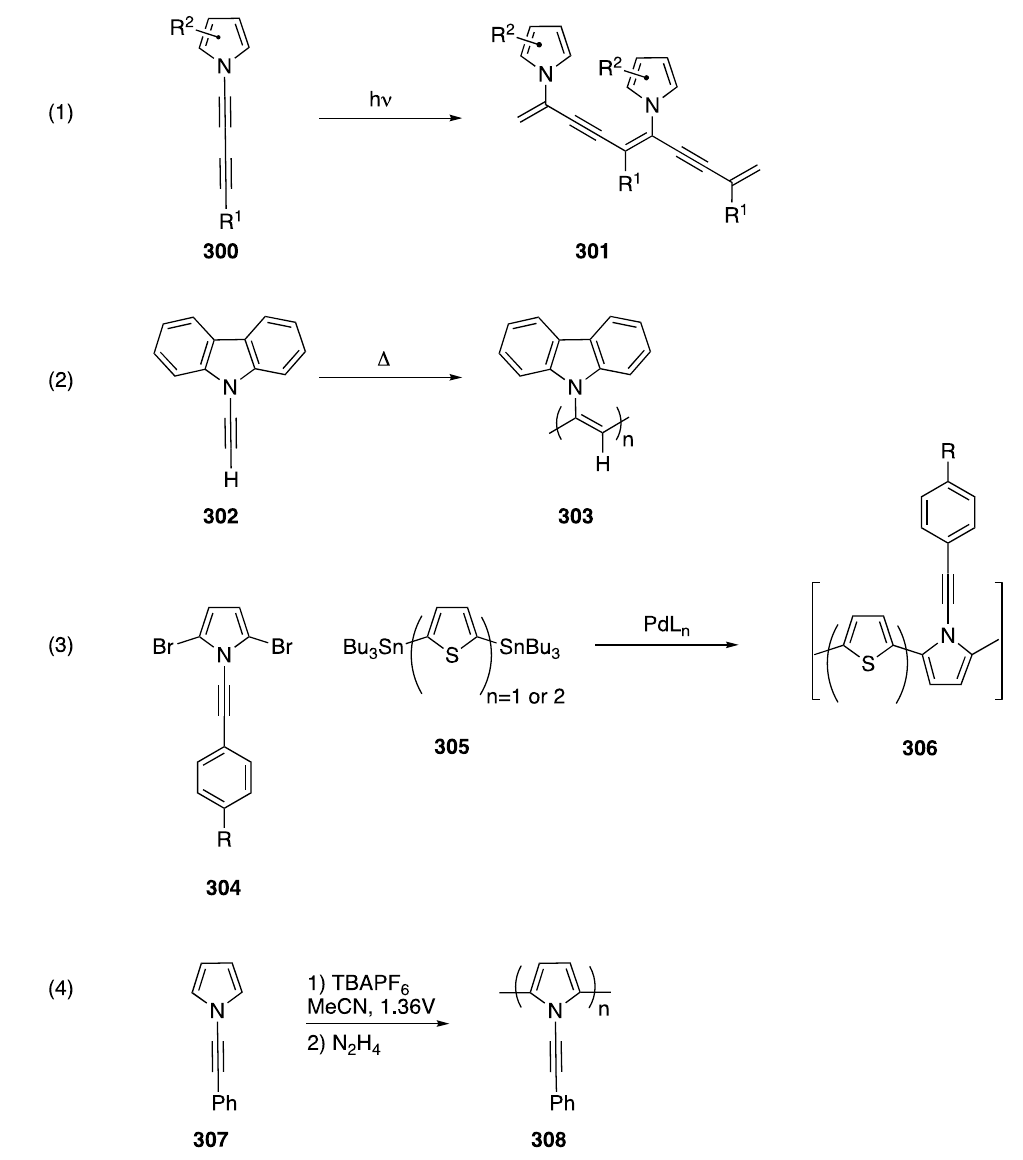
Scheme 80. Application of N -alkynyl azoles in polymerization reactions.